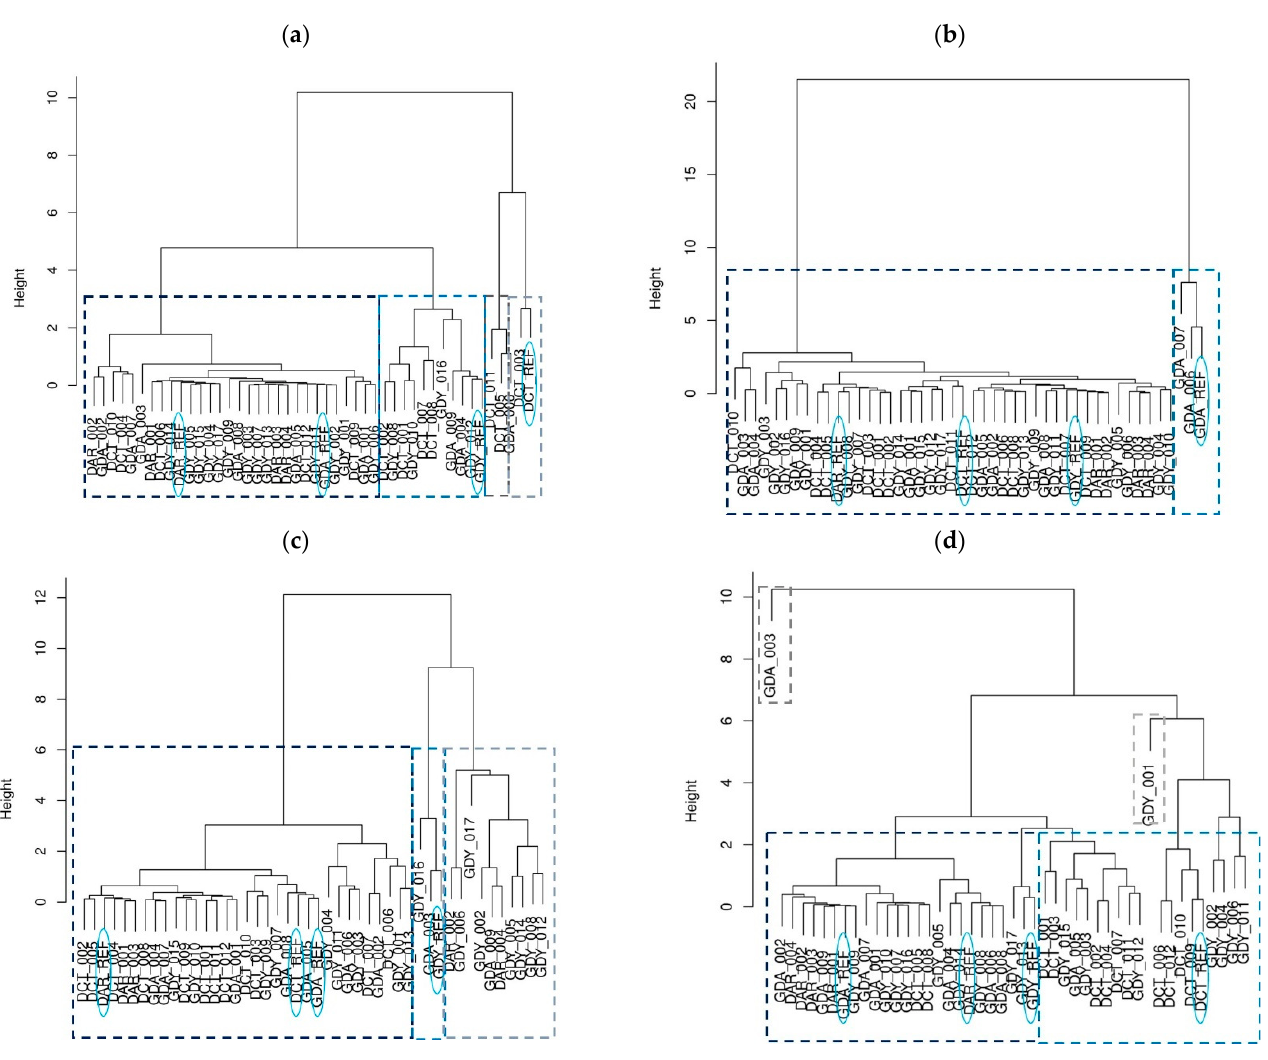
Figure 8. Hierarchical cluster analysis of the sampling sites of the sea dumping sites using biochemical data: ( a ) spring, ( b ) summer, ( c ) autumn, and ( d ) winter.